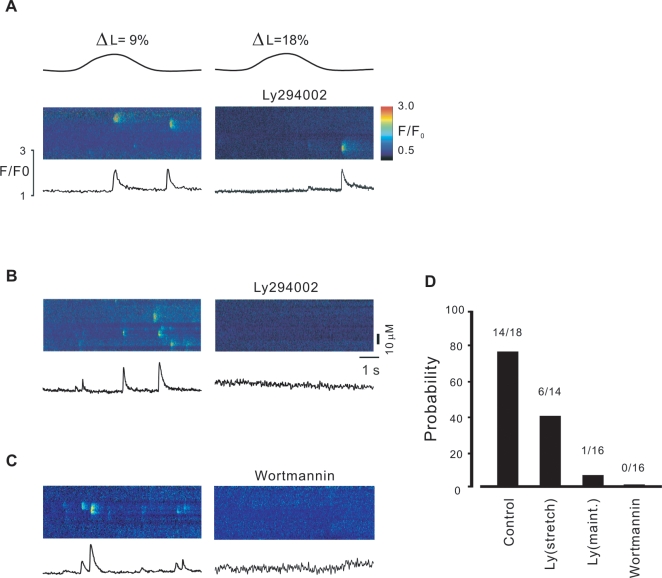
PI(3)k-Akt mediates stretch- induced Ca2+ release in smooth myocytes.Linescan images show the effect of LY492002 on Ca2+ spark at stretch length ΔL = 18%. LY492002 could not completely abrogated the immediately stretch-induced Ca2+ sparks (A), but completely abolished Ca2+ sparks occurred in stretch-maintaining stage (B). C, representatives of experiments in the absence and the presence of another PI3 kinase inhibitor, wortmannin. Like LY492002, wortmannin entirely abrogated Ca2+ sparks occurred in the stretch-maintaining stage. C, summary data of Ca2+ spark probability after sequential stretch. The numbers indicate the response experiments to stretch out of all experiments.